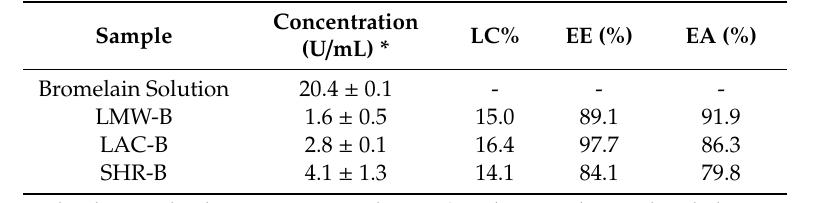
Table 3. Loading capacity (LC%), encapsulation e ffi ciency (EE%) and enzymatic activity of bromelain loaded in the di ff erent types of nanoparticles. The concentration (U / mL) of bromelain in the filtered solution is given as